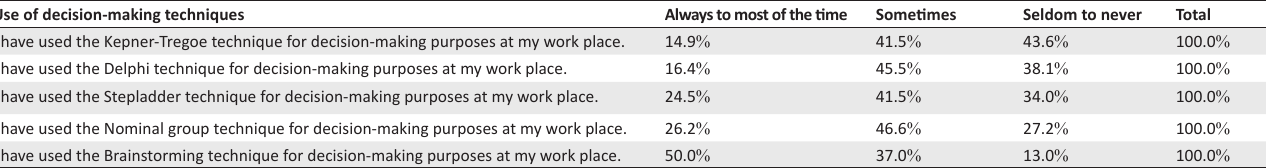
TABLE 3: Frequencies: Use of decision-making techniques. Use of decision-making techniques